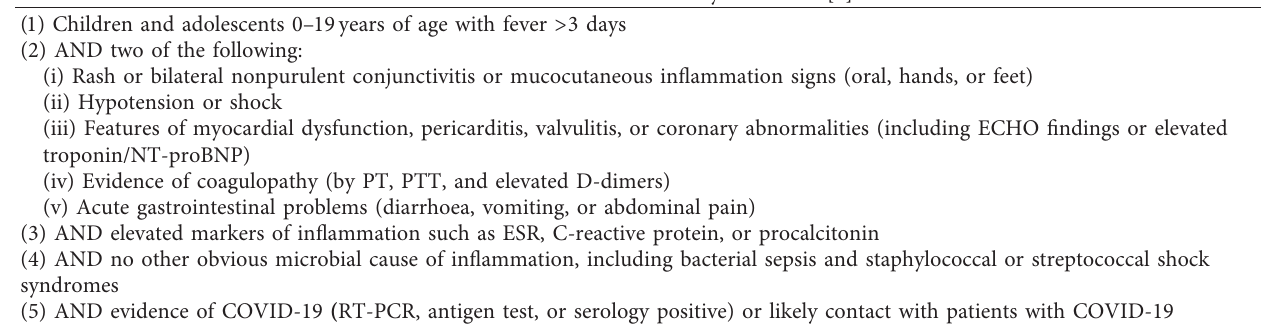
Table 2: Definition of MIS-C by the WHO